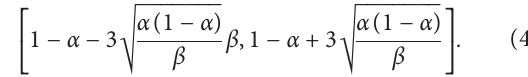
− z plane of 6D FWMHS attractors; 2 3 ; and (f) bifurcation diagram for control 3